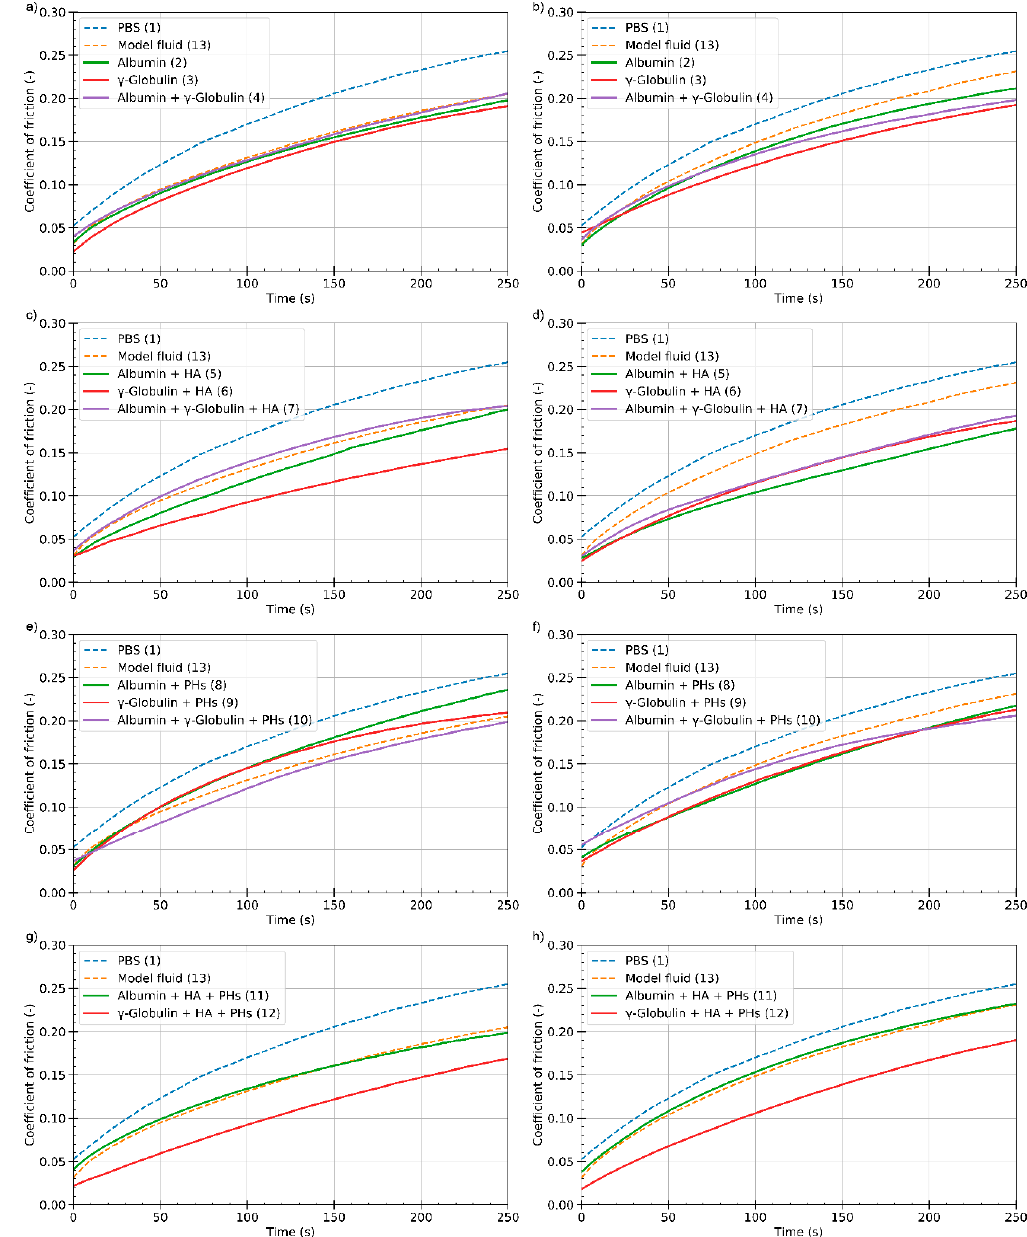
Figure 3. Dependence of the friction coefficient on time for various protein- ( a , b ), HA- ( c , d ), (PHs)- ( e , f ), and HA + PHs- ( g , h ) based lubricants; PC ( left ) and OC ( right ). HA: hyaluronic acid; PH: phospholipids; PC: physiologic concentration; OC: osteoarthritic concentration.